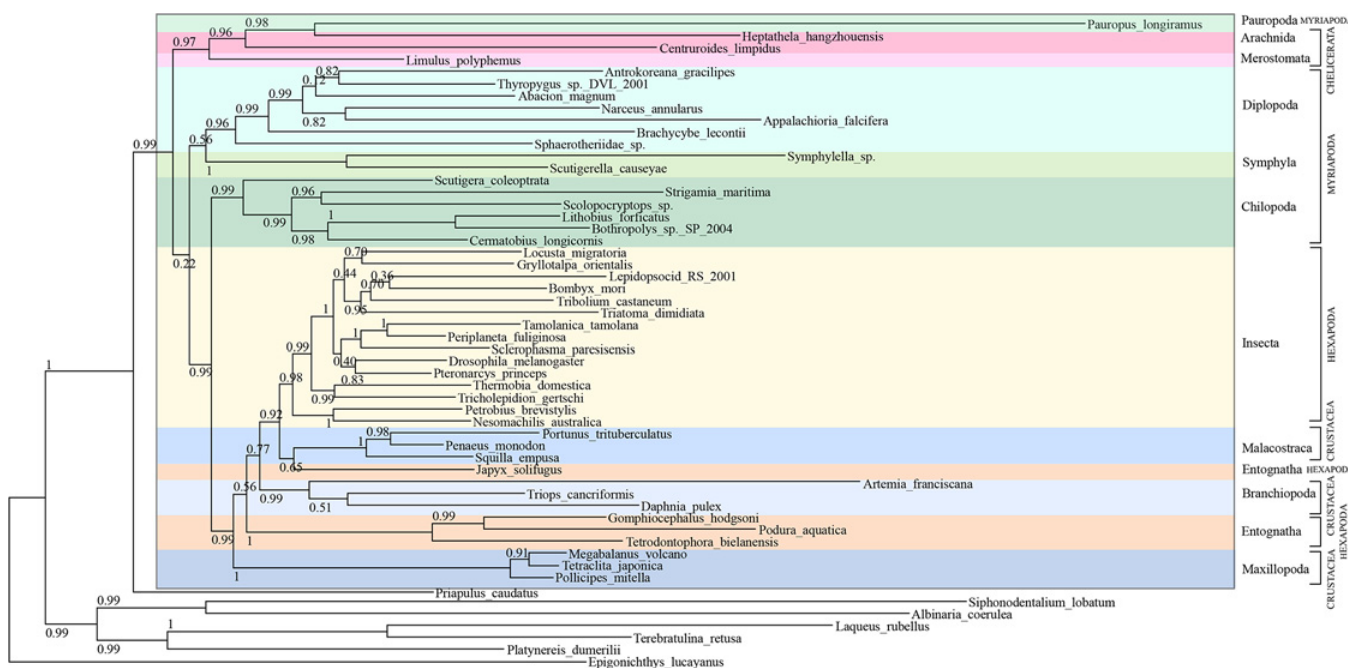
Fig 5. Maximum Likelihood phylogenetic analysis of mitochondrial protein-coding genes from Arthropoda species including S . maritima . Support at nodes are SH-like support values. A monophyletic Chilopoda is resolved as sister group to Pancrustacea (SH-like support = 0.99) and Pauropoda (represented by Pauropus longiramus ) placed as sister group to Chelicerata (SH-like support = 0.97). Within the Chilopoda, Scutigeromorpha ( Scutigera coleoptrata ) are resolved as sister group to the three other chilopod orders represented in our phylogeny (Lithobiomorpha, ( Bothropolys sp ., Lithobius forficatus and Cermatobius longicornis ); Scolopendromorpha ( Scolopocryptos sp .) and Geophilomorpha ( Strigamia maritima ) with SH-like support = 0.99.